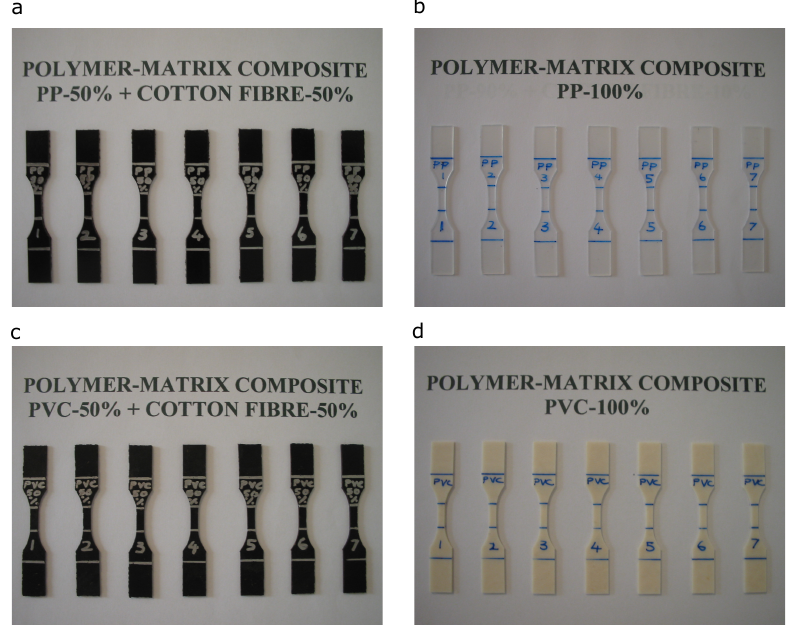
Figure 3. Selected set of dumbbell-shaped test coupons: ( a ) PP-50%/CF-50%, ( b ) PP-100%, ( c ) PVC-50%/CF-50%, and ( d )